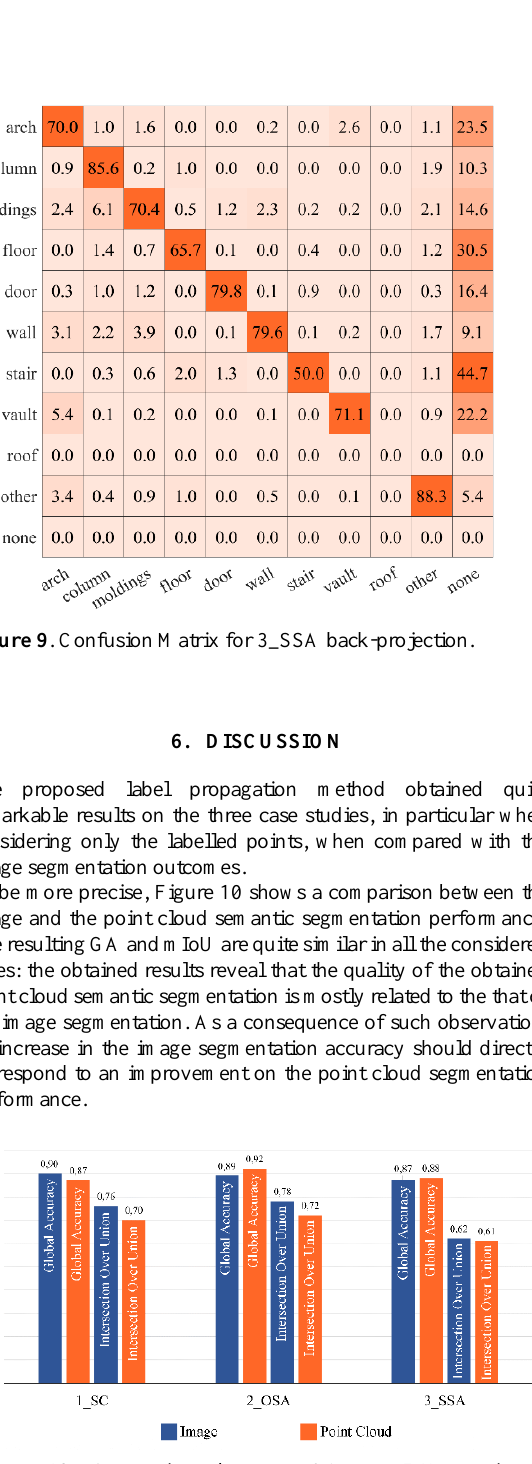
Figure 10 . Comparison between GA e mIoU on image segmentation (blue) and on the point cloud segmentation